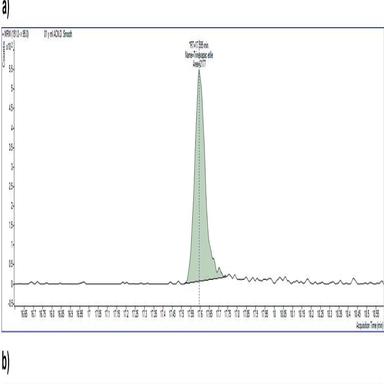
EC formulation: Trinexapac ethyl in pristine form by GC-MS/MS a) and by HPLC-DAD b).